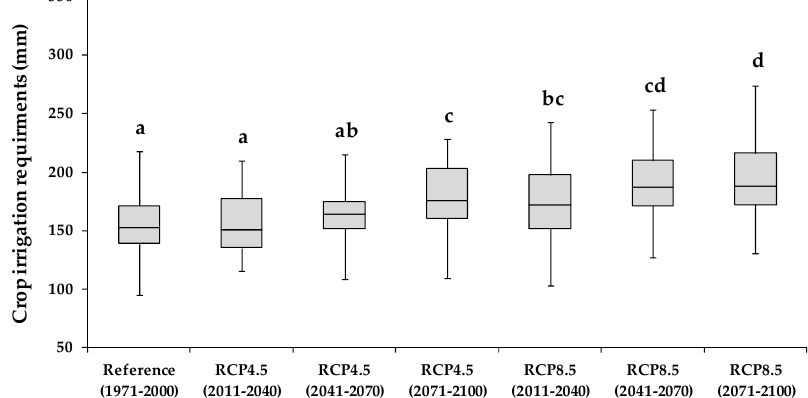
Figure 6. Box plots of crop irrigation requirements (mm), for the climate scenarios under deficit irrigation management (DIM). a–d letters indicate significant statistical differences at p = 0.05.